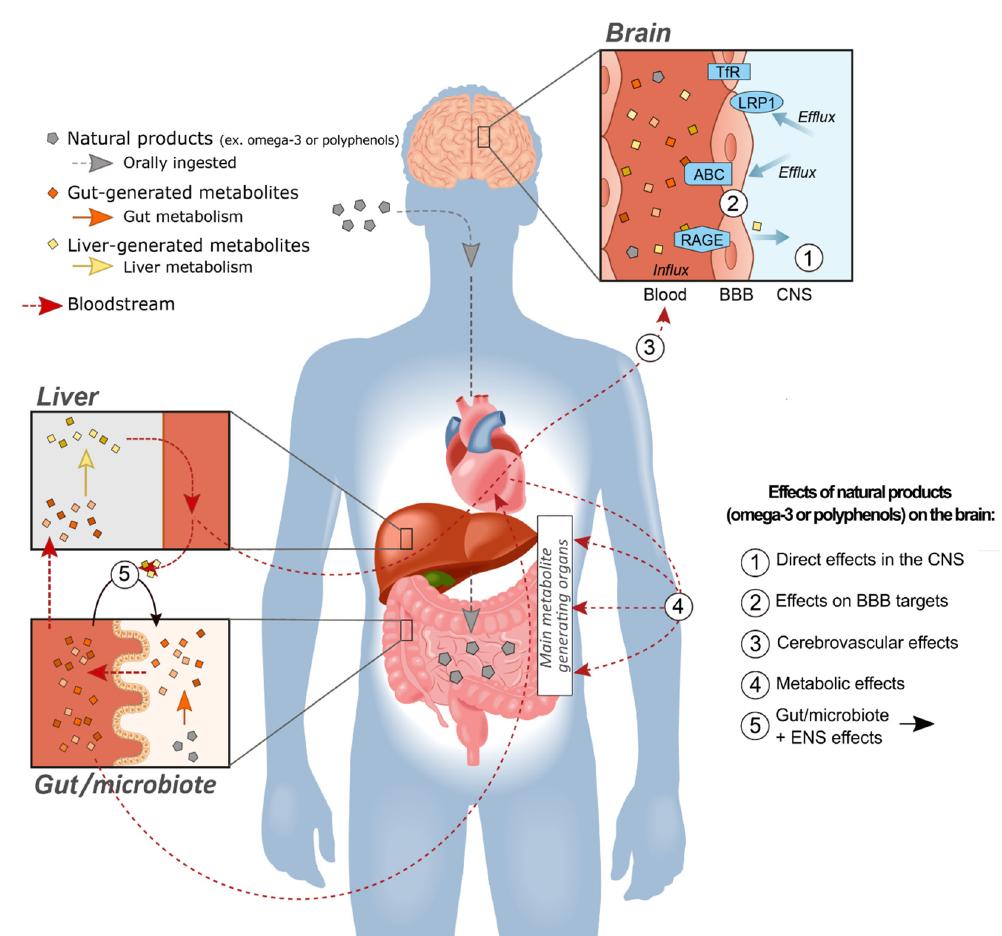
Figure 1. Natural products (NPs), such as omega-3 polyunsaturated fatty acids (n-3 PUFAs) or polyphenols, can alter brain function and improve brain health through multiple pathways. NPs are first orally ingested and once in the gut, they are transformed into a wide diversity of metabolites, which can cross the intestinal epithelial barrier to reach the circulation. The metabolites generated by the gut microbiota can then undergo first-pass metabolism in the liver and phase II enzymatic conversion, such as glucuronidation and sulfation. Once in the bloodstream, NPs and gut/liver-generated metabolites can have direct effects (1) on the central nervous system (CNS) for the small subset of compounds crossing the blood–brain barrier (BBB) in sufficient quantity. Alternatively, other can have indirect effects (2) on BBB targets in brain capillary endothelial cells (BCECs) by modulating cell-signaling processes, or by balancing the influx and/or efflux mechanism under the control of several transporters (e.g., the receptor for advanced glycation end products/RAGE, low-density lipoprotein receptor-related protein 1/LRP1 and various ATP-binding cassette transporters/ABC). In addition, (3) NPs and their metabolites can improve cerebrovascular condition by enhancing cerebral blood flow, glucose uptake and/or brain oxygenation, which are critical for many CNS diseases. Further outside of the brain, circulating NPs and metabolites may impact (4) key organs regulating peripheral metabolism, to enhance the metabolic determinants, such as glucose, insulin and several metabolic hormones that might exert long-term therapeutic effects on the brain. Finally, (5) NPs can interact with the brain via the gut–microbiota–brain axis through multiple mechanisms. In part through its effect on NP metabolism, the gut microbiota can generate CNS-acting compounds in the systemic circulation, while the enteric nervous system (ENS) is connected with the CNS through the vagus nerve. Polyphenols are predominantly metabolized in the gut and the liver, thereby generating metabolites that can act on the brain through these 5 pathways. However, low brain bioavailability precludes most polyphenols to run through pathway 1. In contrast, n-3 PUFAs are more likely to act directly in the brain (pathway 1), but can also engage pathways 2, 3, 4 and 5.